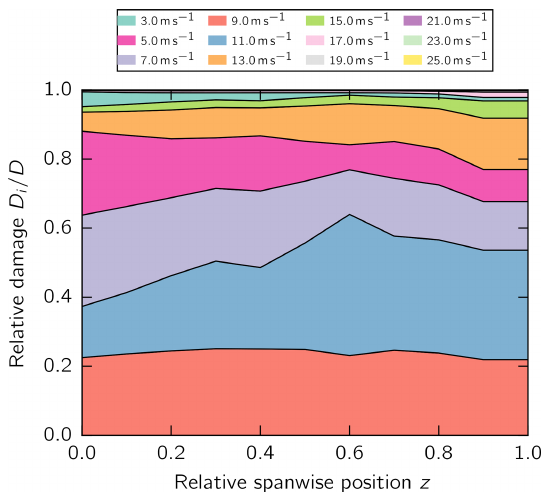
Figure 9. Relative damage from static simulation.